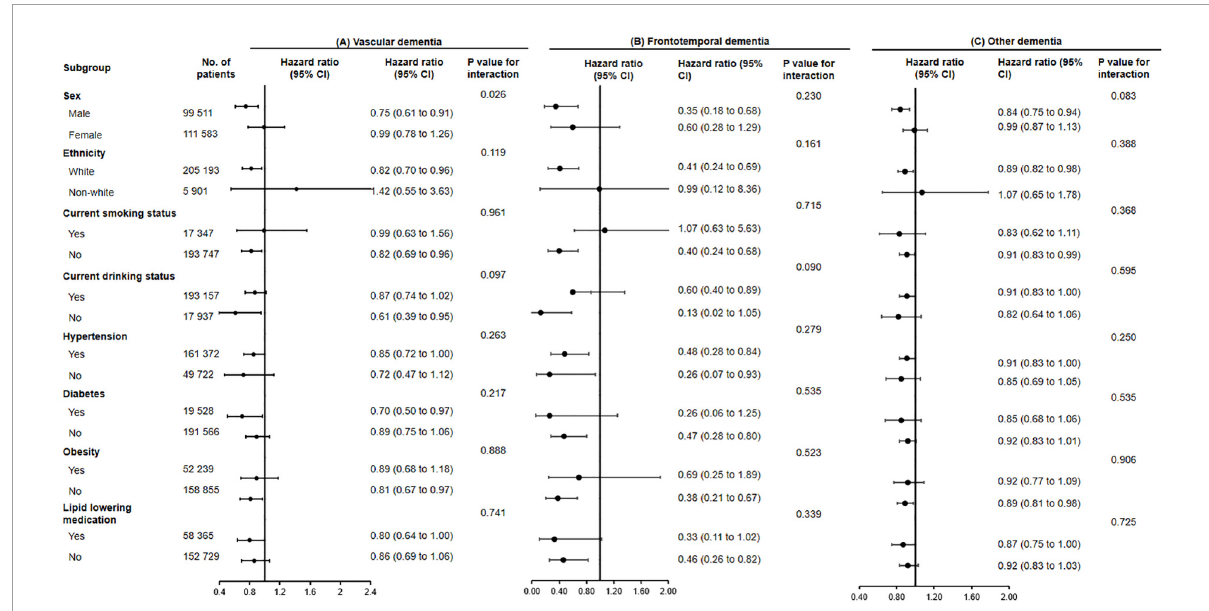
FIGURE2 The association of fish oil supplementation and vascular dementia (A) , frontotemporal dementia (B) , and other dementia (C) in different subgroups. Results were adjusted for age, gender, ethnicity (white, black, Asian, Chinese, mixed, or other ethnic group), education level, smoking status (never, former, or current), alcohol consumption (never, former, or current), hypertension (yes or no), antihypertensive drug use (yes or no), aspirin use (yes or no), lipid lowering medication (yes or no), other vitamin or mineral or dietary supplementation (yes or no), Townsend Deprivation Index, household income [ < £18,000 (€21,489; $23,253), £18,000–£30,999, £31,000–£51,999, £52,000–£100,000, or > £100,000], physical activity ( < 150 or ≥ 150